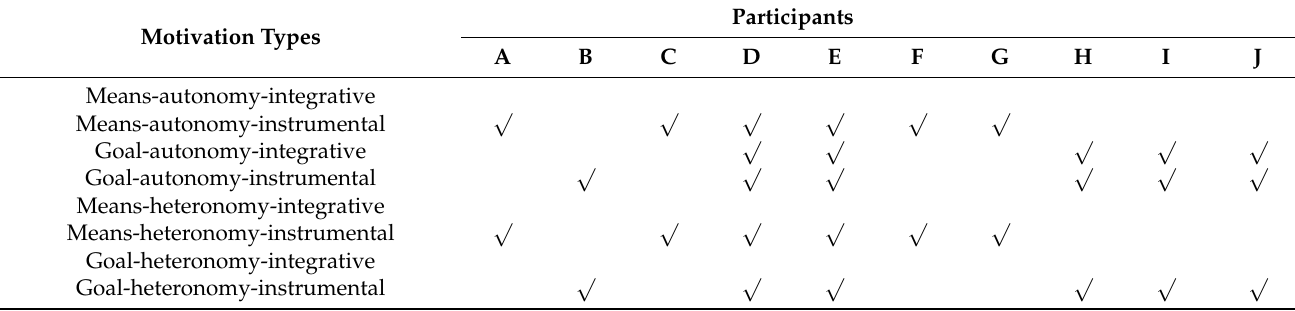
Table 5. Motivation types of English and non-English